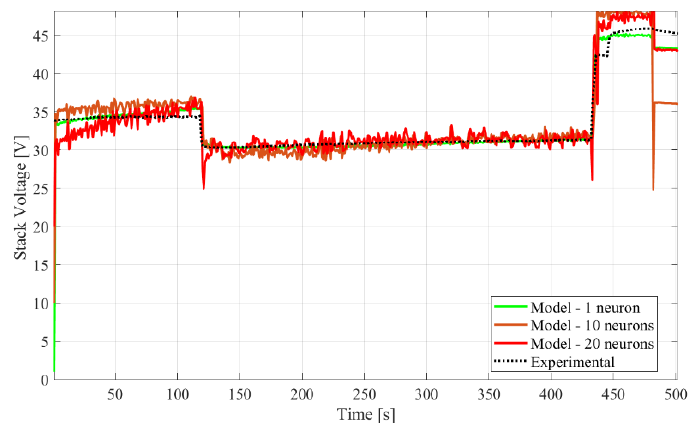
Figure 8. Experimental and model responses of the stack voltage using an ANN with the SCG algorithm.